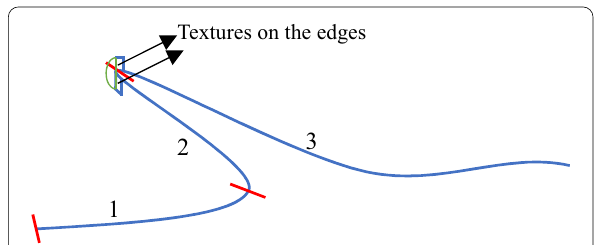
Figure 8 A graph of a relation that is not a function with division planes